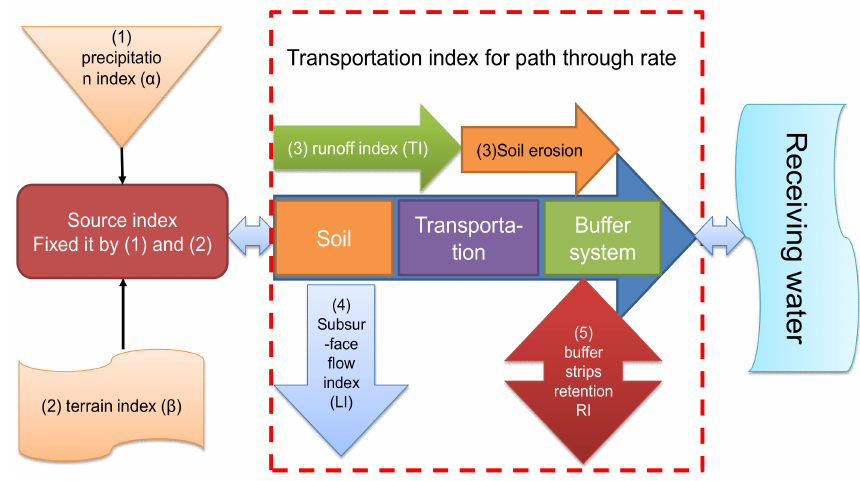
Figure 1. Technical framework of the PTRFFM.